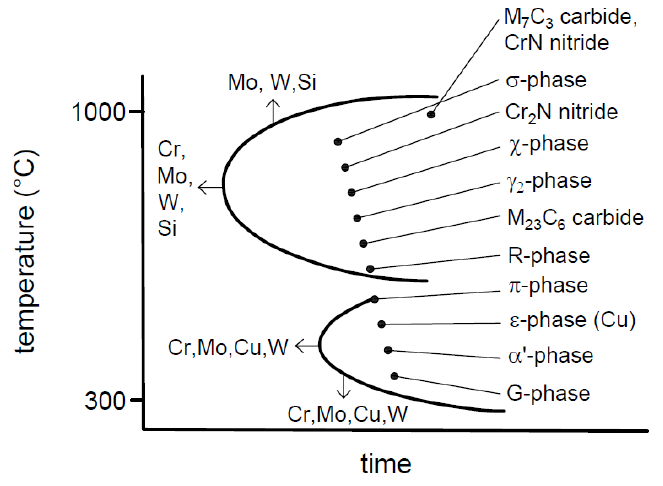
Figure 1. Typical precipitations of duplex stainless steel.